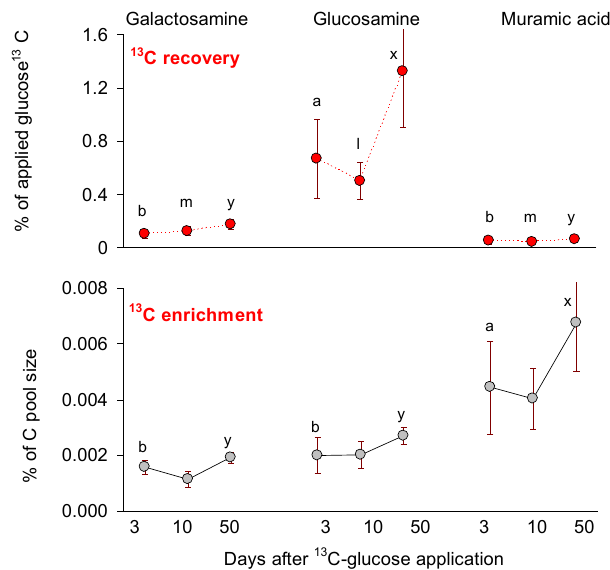
Figure 4. Recovery of glucose-derived 13 C (top) and 13 C enrich- ment (bottom) of amino sugars and muramic acid. Letters reflect significant differences in the recovery and 13 C enrichment from glu- cose 13 C into amino sugars on a particular day; letters (a–b) are for day 3, (l–m) are for day 10, and (x–y) are for day 50. No significant differences were observed between the three sampling days. Data present mean ( n = 4) and bars present standard